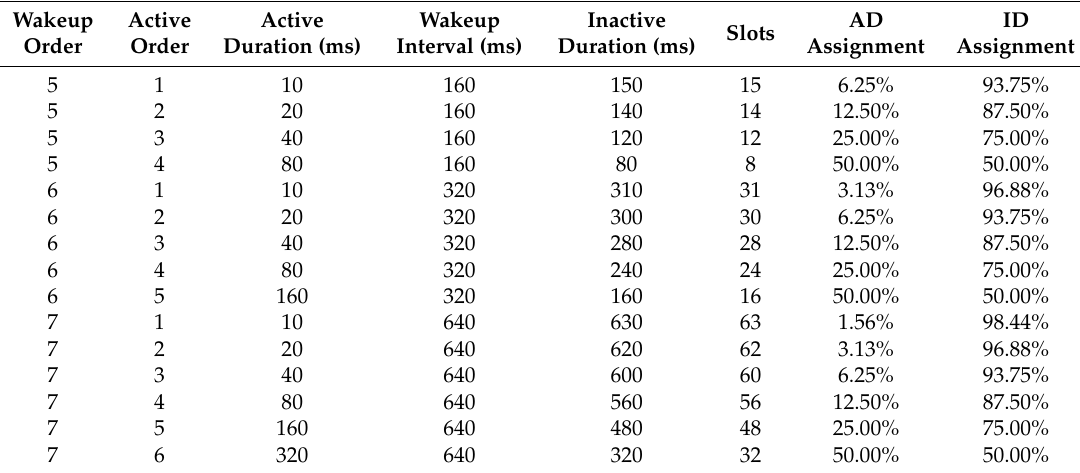
Table 5. Active and inactive durations according to